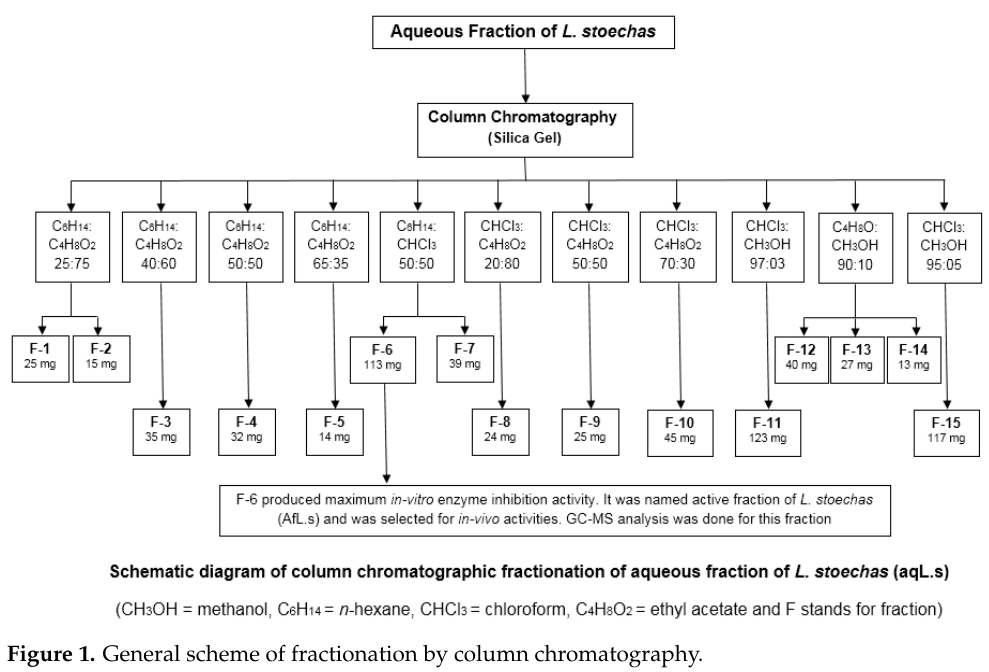
Figure 1. General scheme of fractionation by column chromatography.